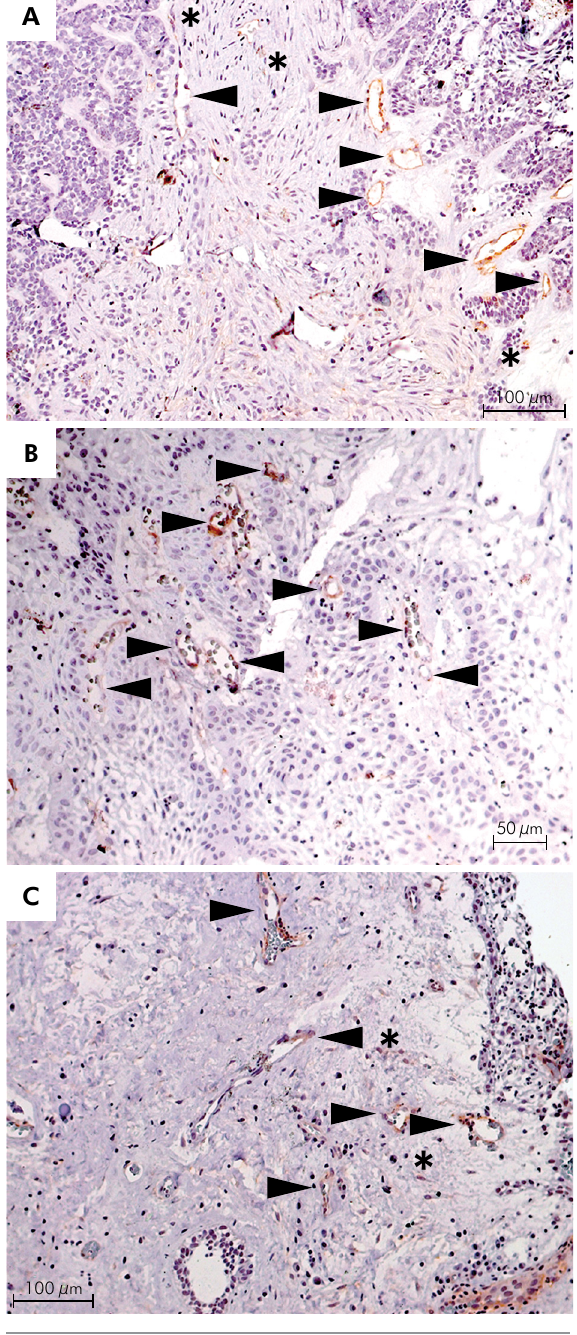
Figure 1. Immunohistochemical expression of CD90 in multicystic and unicystic ameloblastomas. (A, B) Cytoplasmic CD90 expression in the fibroblasts (asterisk) and vascular endothelial cells of the multicystic ameloblastoma tumor stroma, near the cords/nests of neoplastic odontogenic epithelia (arrows head). (C) Illustrates a weak cytoplasmic CD90 expression in a unicystic ameloblastoma in the capsular connective tissue of the tumor (fibroblasts – asterisk; vascular endothelial cells – arrows head). Magnification indicated in the scale bar.